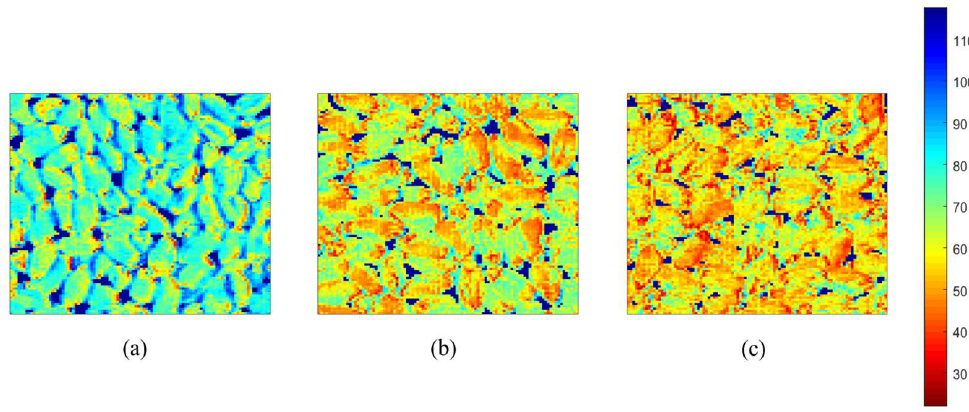
Figure 9. Visible distribution of catalase activity. The color of the image changed from blue to green and from yellow to red. The bluer the color is, then the higher the CAT value is, which means that the wheat is newer. The redder the color is, the lower the CAT value is, indicating that the wheat is older. As shown in Figure 9a, when the CAT = 112.78 mg H 2 O 2 /g, and the wheat is of grade I and is fresh, the overall image is blue-green, and yellow and red colors are slightly distributed.